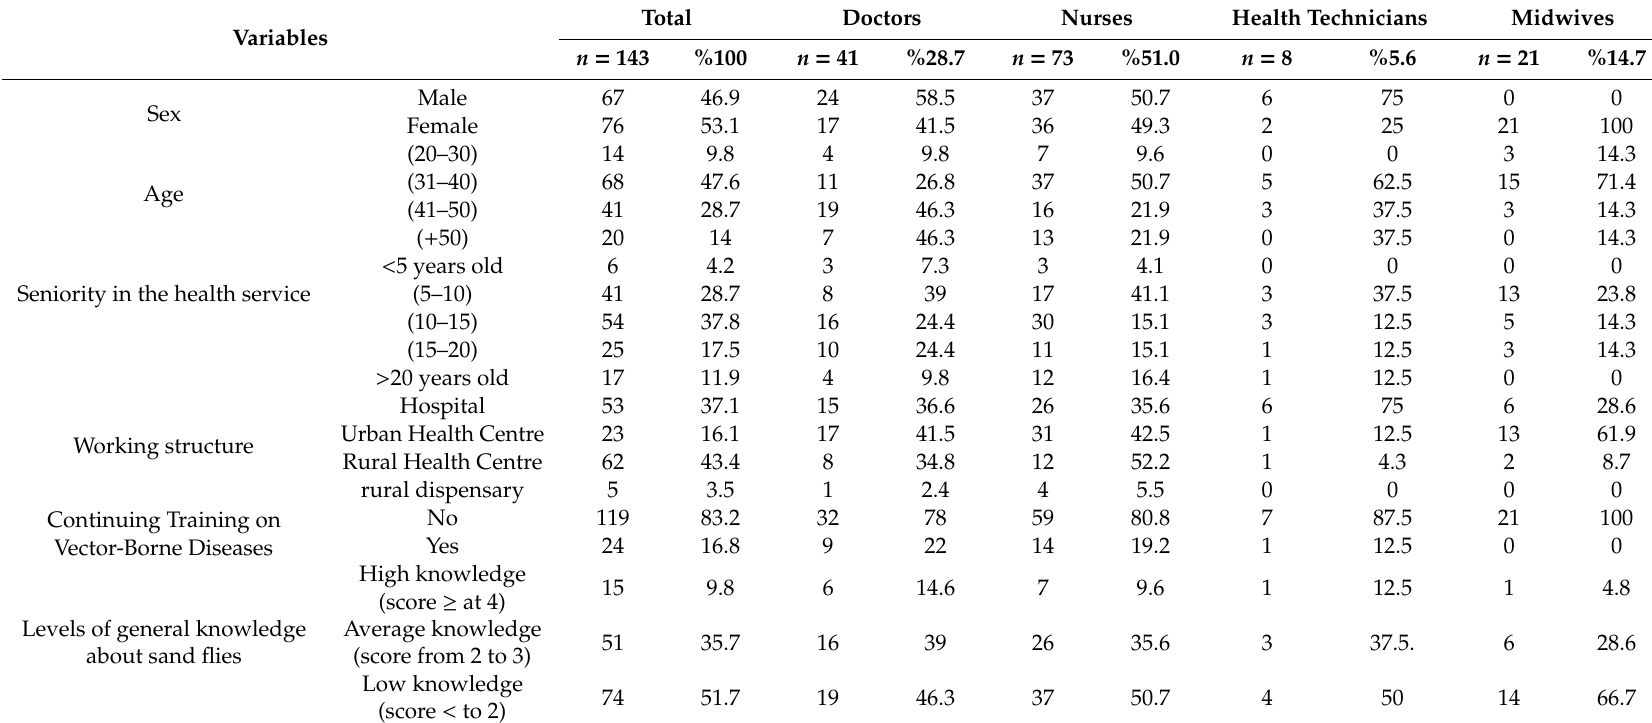
Table 1. Socio-professional characteristics and levels of knowledge of health professionals about sand